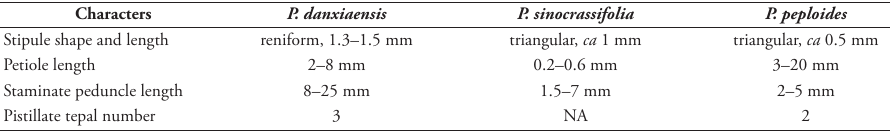
Table 4. Diagnostic comparison of Pilea danxiaensis , P. sinocrassifolia and P. peploides .